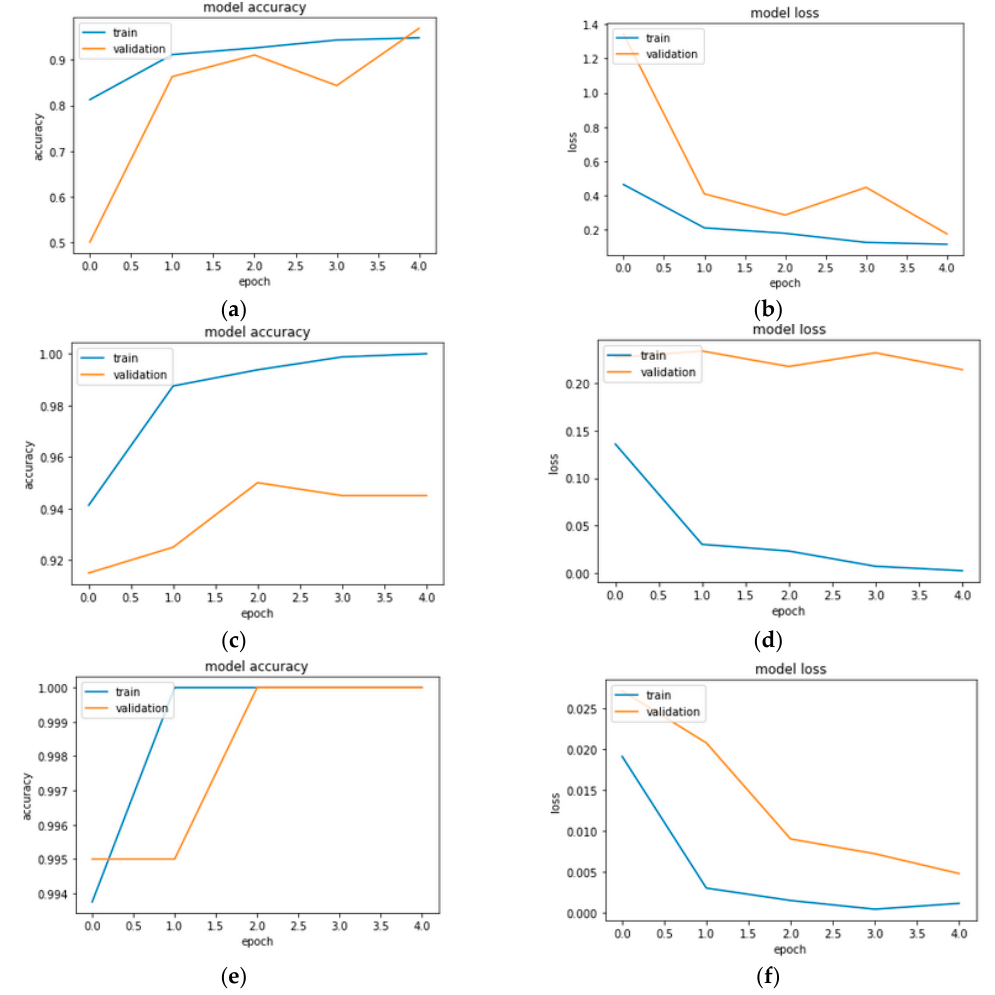
Figure 11. Validation and training analysis over five epochs of the pre-trained EfficientNetB7 model using various datasets: ( a ) validation and training model accuracy analysis, using the Clarkson 2015 dataset; ( b ) validation and training model loss analysis, using the Clarkson 2015 dataset; ( c ) validation and training model accuracy analysis, using the IIITD dataset; ( d ) validation and training model loss analysis, using the IIITD dataset; ( e ) validation and training model accuracy analysis, using the ND_Iris3D_2020 dataset; and ( f ) validation and training model loss analysis, using the ND_Iris3D_2020 dataset.